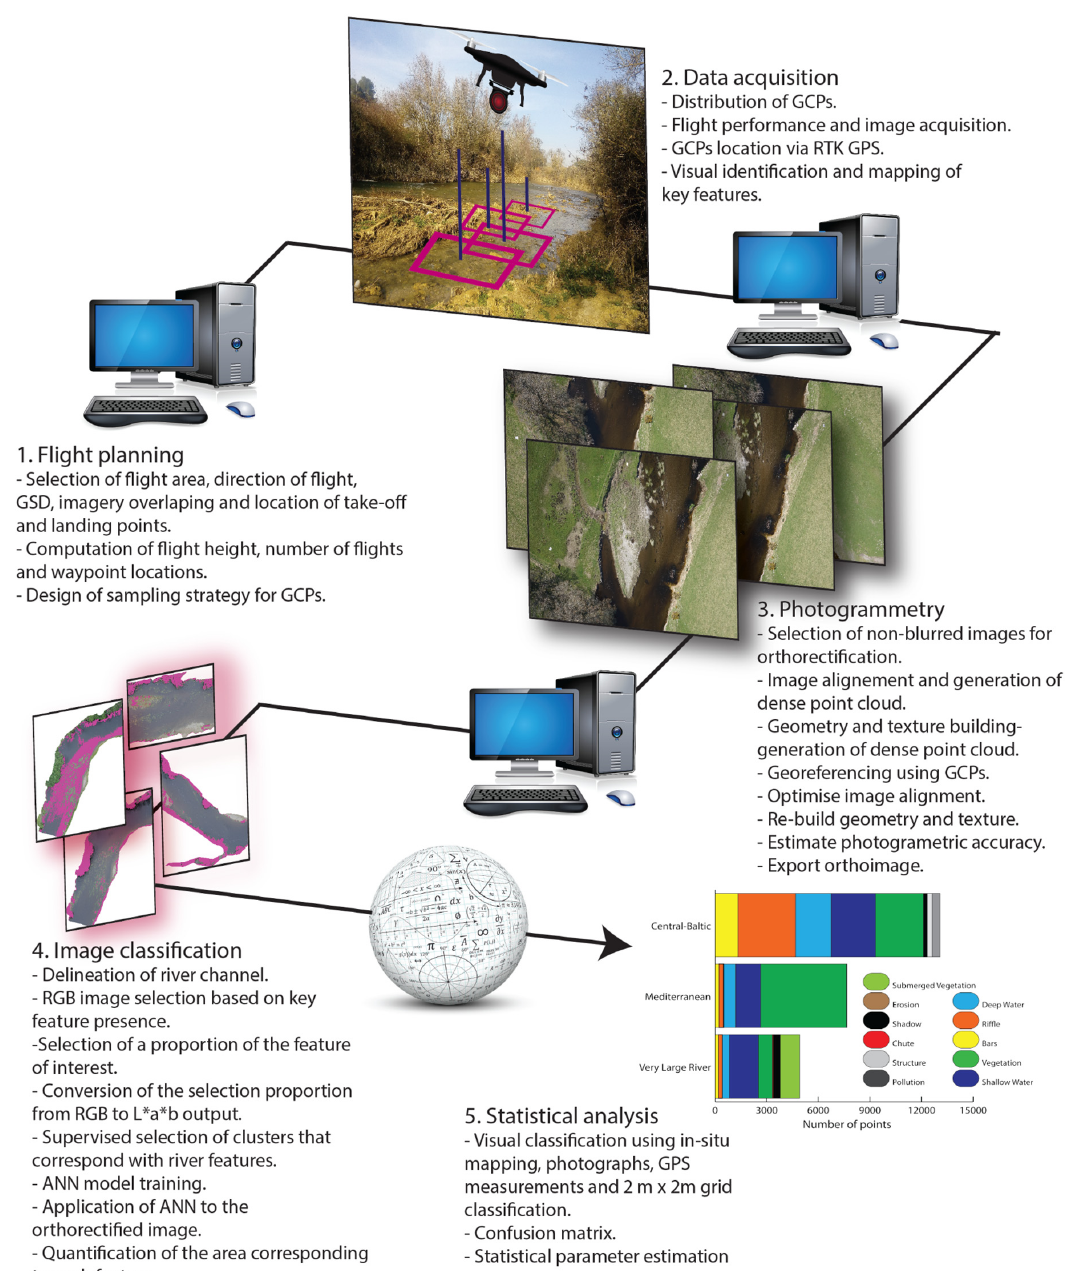
Figure 4. Workflow followed from imagery collection to multiple comparison analysis. ANN, GCP and GSD stand for artificial neural network, ground control point and ground sampling distance,